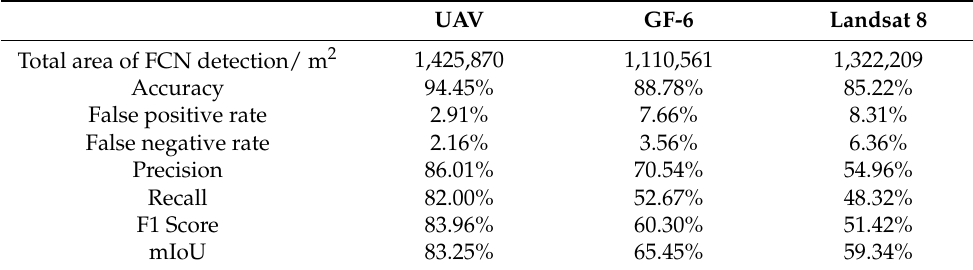
Table 3. Landslide detection results from remote sensing